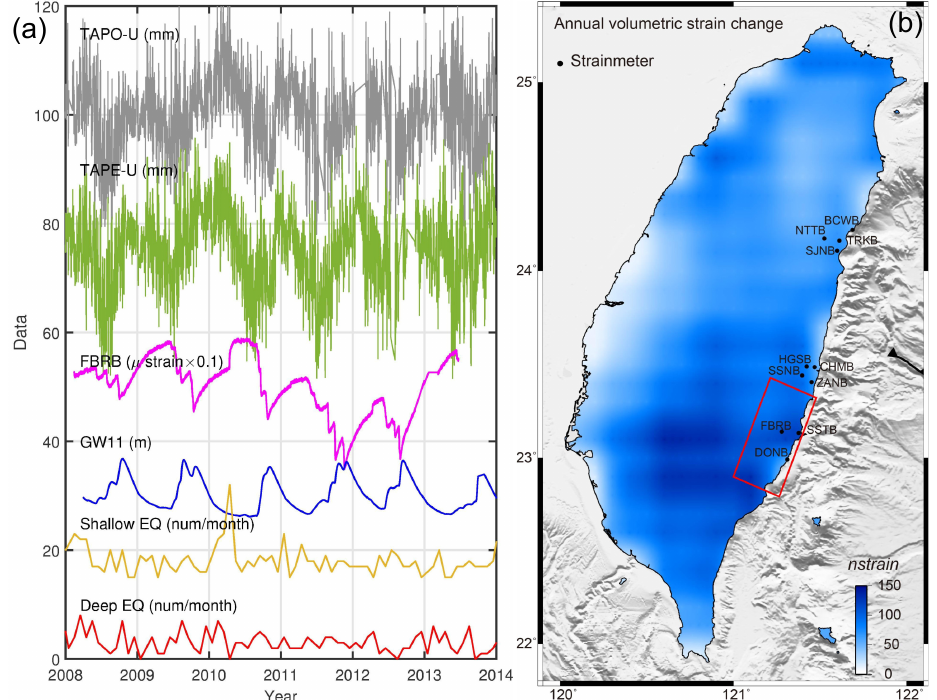
Figure 18. Annual variations due to hydrological cycles. ( a ) GNSS vertical position time series at sites TAPE and TAPO across the LVF (see Figure 2 for station locations). Magenta and blue lines show the time series of volumetric strain at FBRB and groundwater level at the station GW11. Orange and red lines indicate shallow and deep earthquakes in the southern LVF (red box in ( b )). The depth threshold is about 17 km which divides the declustered catalog using the nearest neighbor algorithm [73] into similarly sized numbers of events. ( b ) Volumetric strain change at the depth of 1 km due to seasonal hydrological loading. Change are estimated using a 1D spherical layered Earth model [74] and multiple vertical source loading [70,75] with amplitudes constrained by disk loads